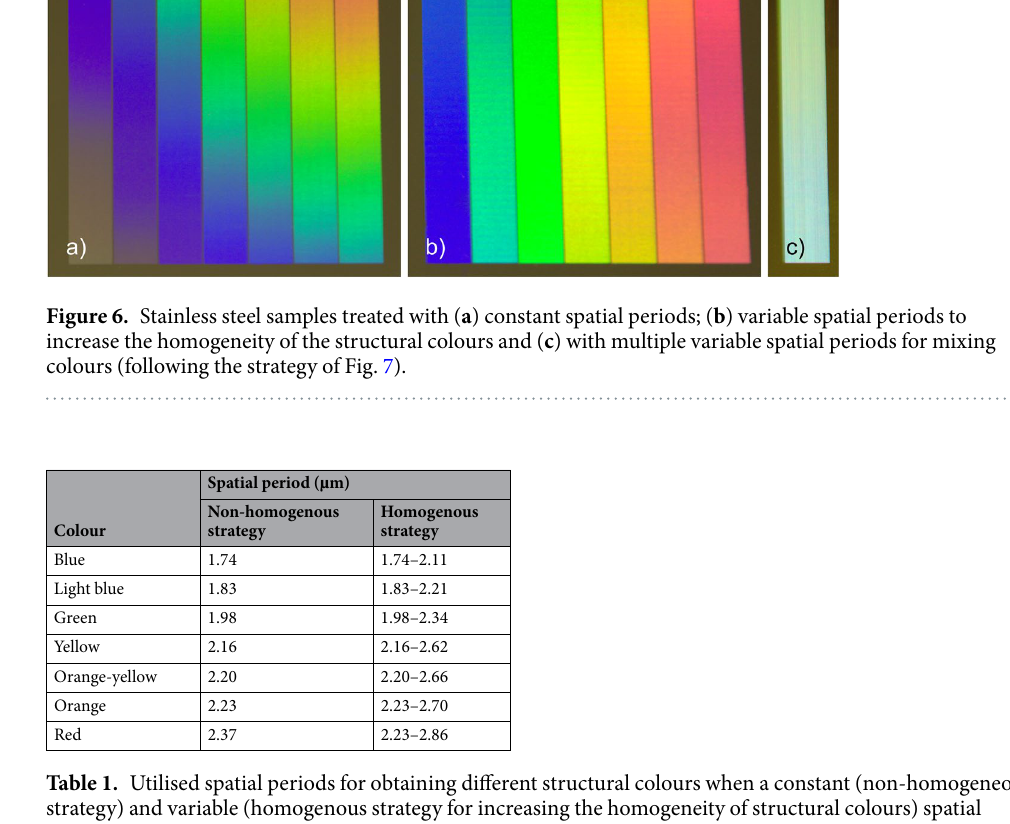
d = 105 mm (for a viewing angle of 22° and height of 50 cm).